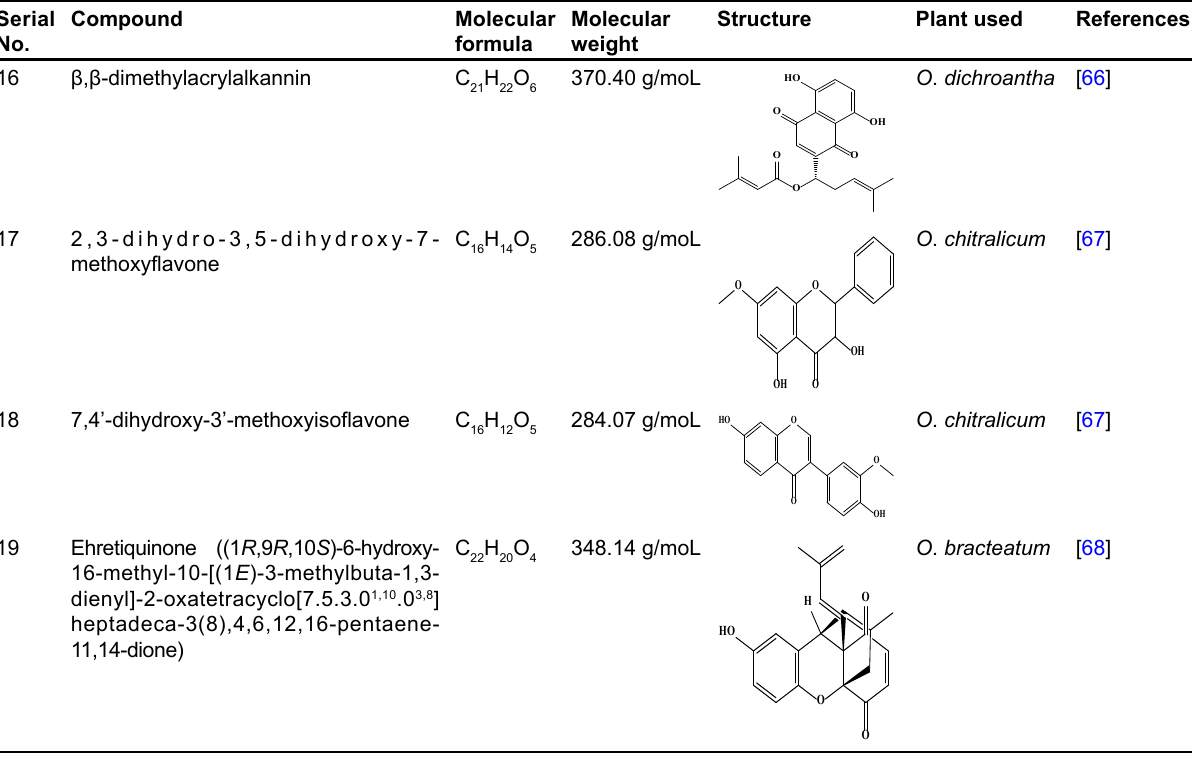
O echioides . has reduced oxidative